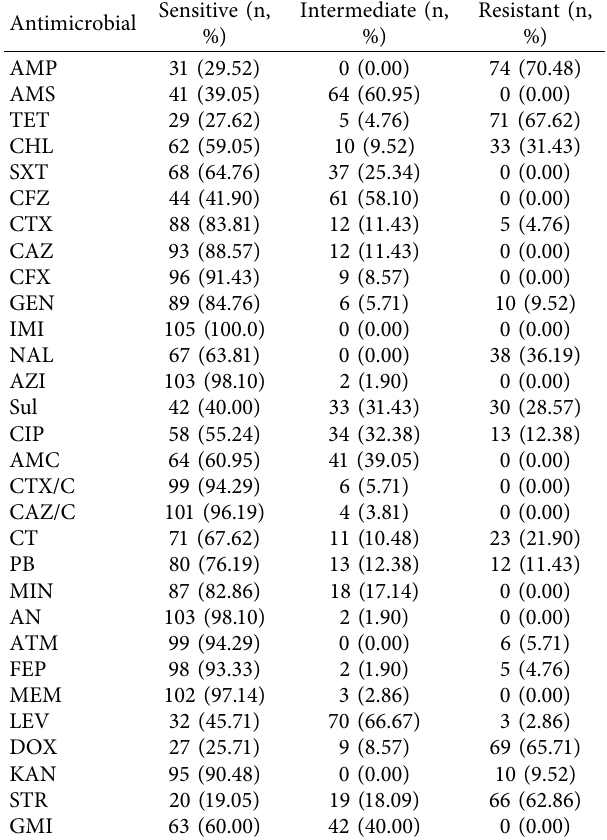
Table 1: Number of isolates and prevalence at 95% CI of salmonella serotypes in 105 Salmonella strains collected from 2018 to 2020 in six sentinel hospitals from Huzhou, Zhejiang,